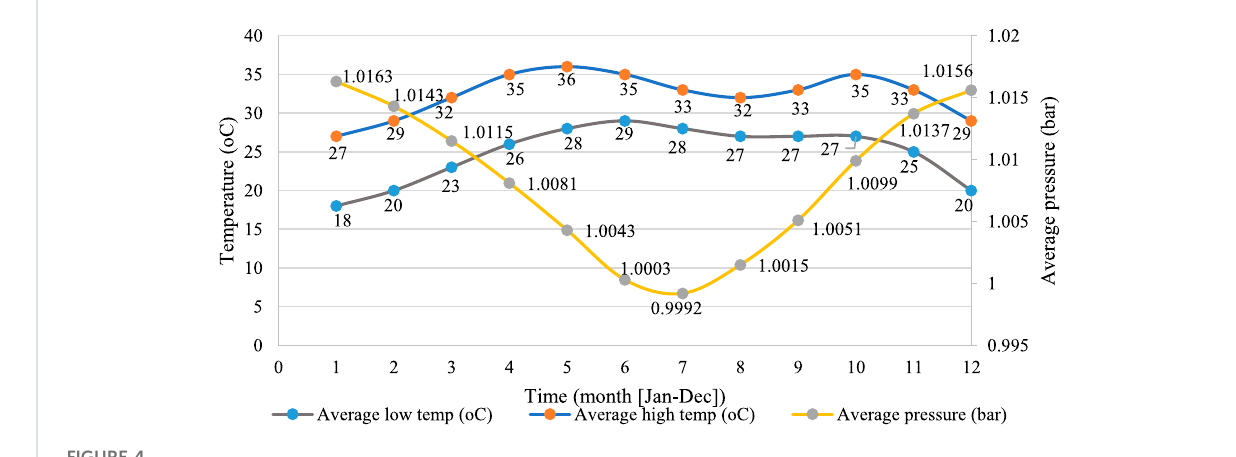
FIGURE 4 Average temperature and pressure of the Gharo site.